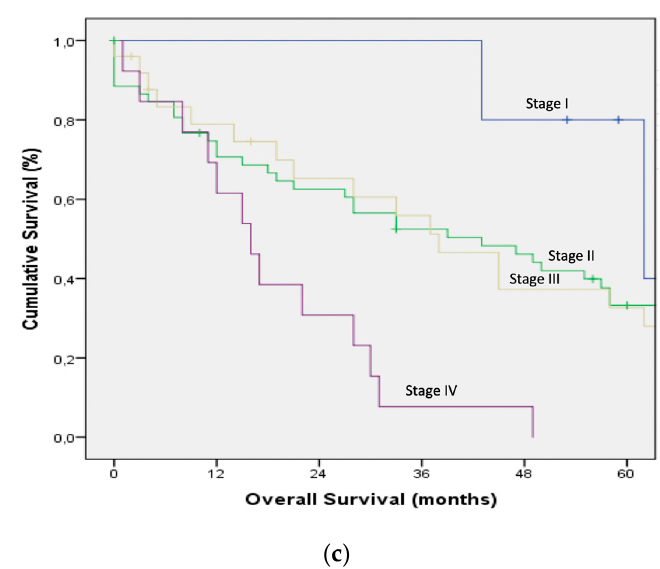
Figure 1 ( a ) Overall survival by the main stages according to the 6th edition of the American Joint Committee on Cancer staging system. ( b ): Overall survival by the main stages according to the 7th edition of the American Joint Committee on Cancer staging system. ( c ). Overall survival by the main stages according to the 8th edition of the American Joint Committee on Cancer staging system.